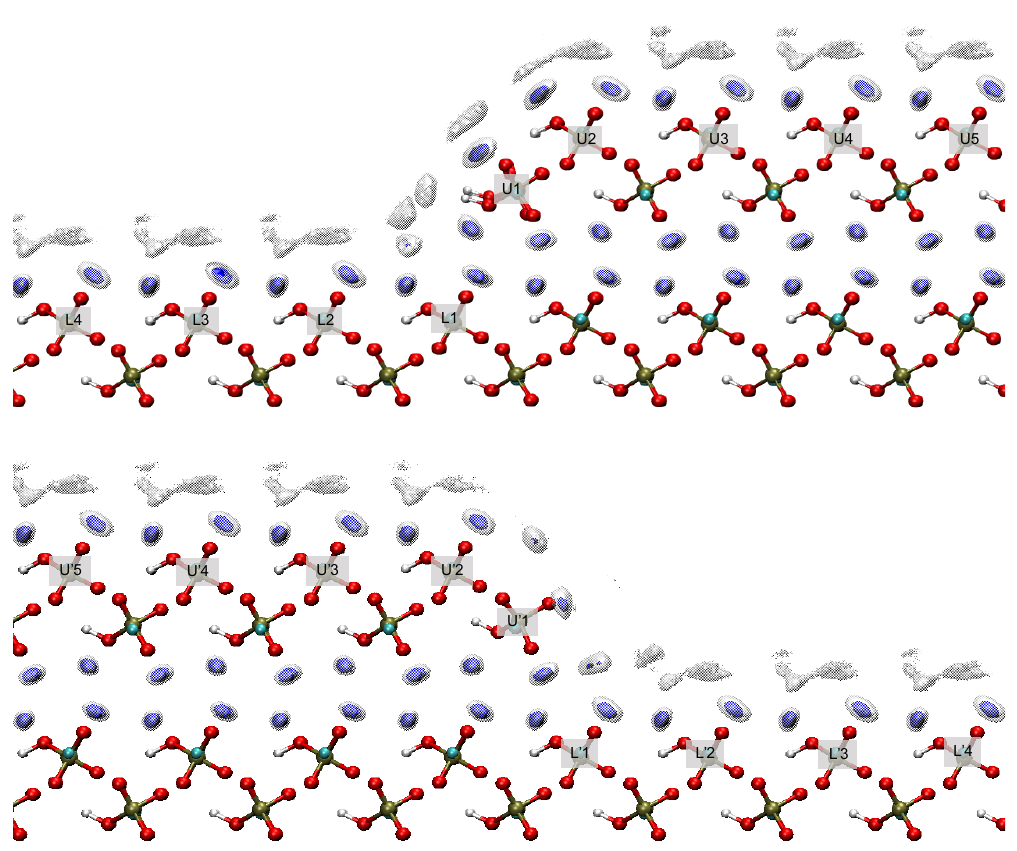
Figure 6. Side view of the 3D density maps of the [101] steps with ( Top ) hydrogens facing outward towards water (L or U) and ( Bottom ) hydrogens facing inward towards the bulk (L’ or U’) on the {010} face. Average positions of the phosphate and calcium ions are represented with a ball and stick model where H is white, O is red, P is tan, and Ca is cyan (all isosurfaces set to 2 atoms/Å 3 ). For water, the isosurfaces shown are in transparent colours where the darker shade is used for the higher density (blue: 2 atoms/Å 3 and grey 0.05 atoms/Å 3 ). Labels indicate the atomic row position (Upper or Lower) and its proximity to the step (1, 2, 3, 4 or 5) using the same notation established for calcite